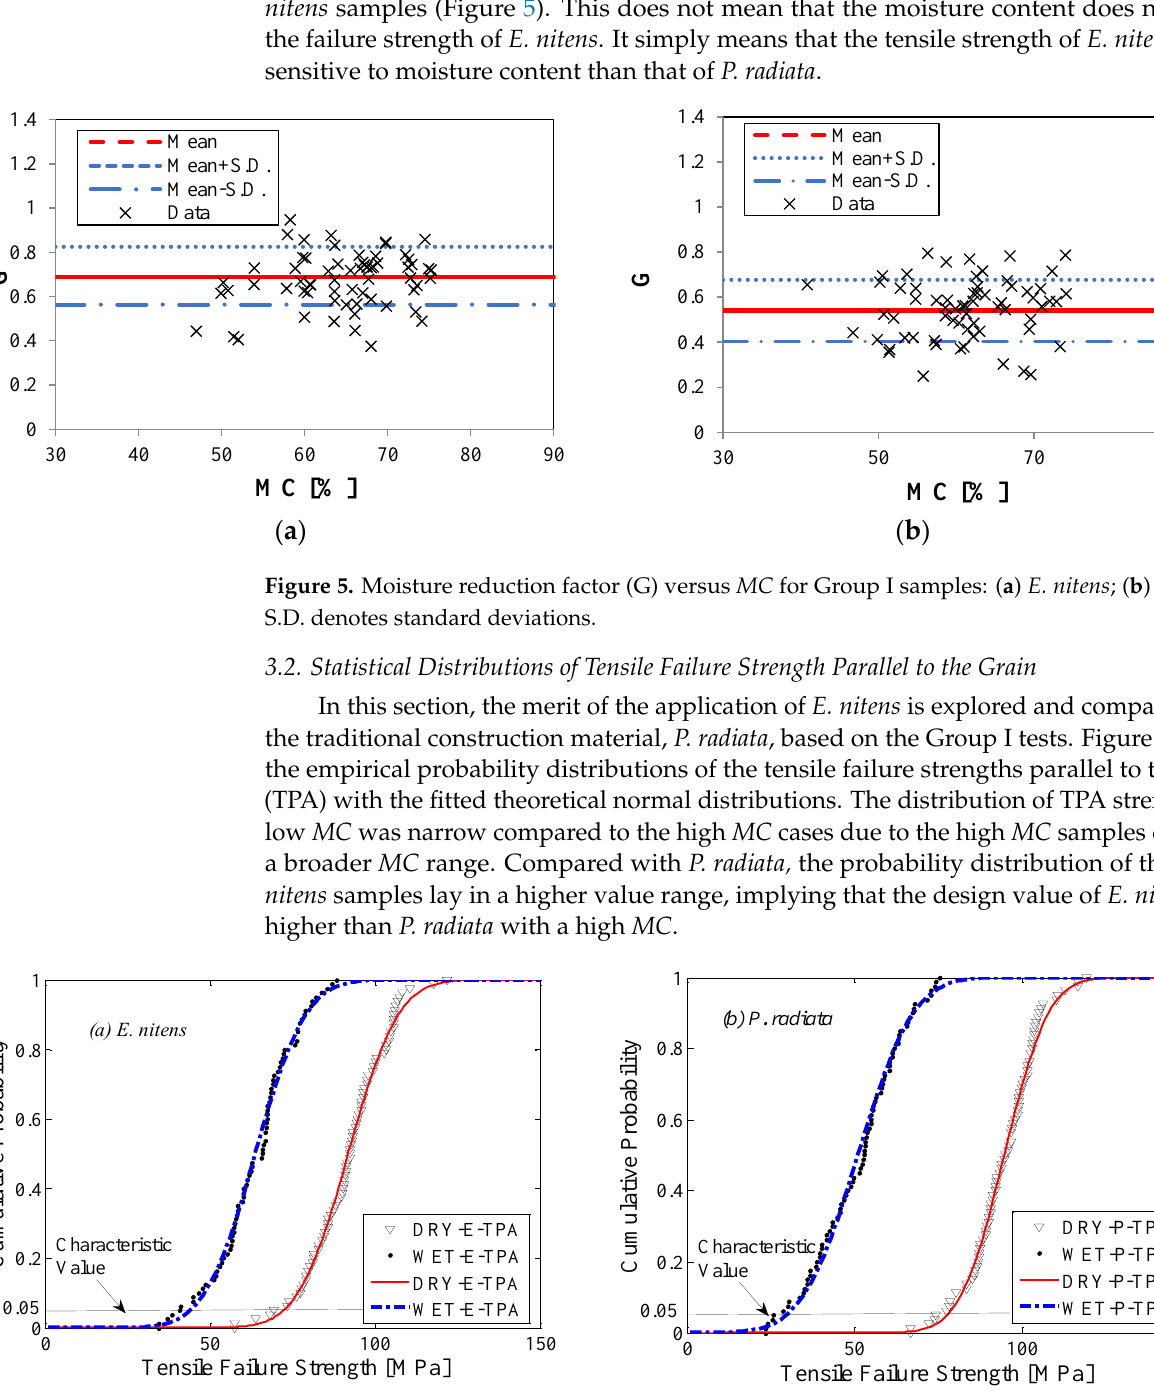
Figure 6. Cumulative probability distributions of experimental tensile failure strength (points) for low and high MC samples: ( a ) E. nitens ; ( b ) P. radiata . The lines are the fitted theoretical normal distributions.